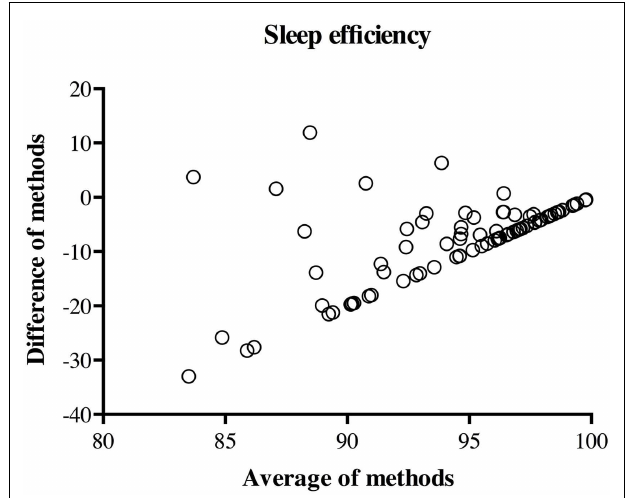
FIGURE 2 | Plot of between-methods difference by across-method average for sleep efficiency